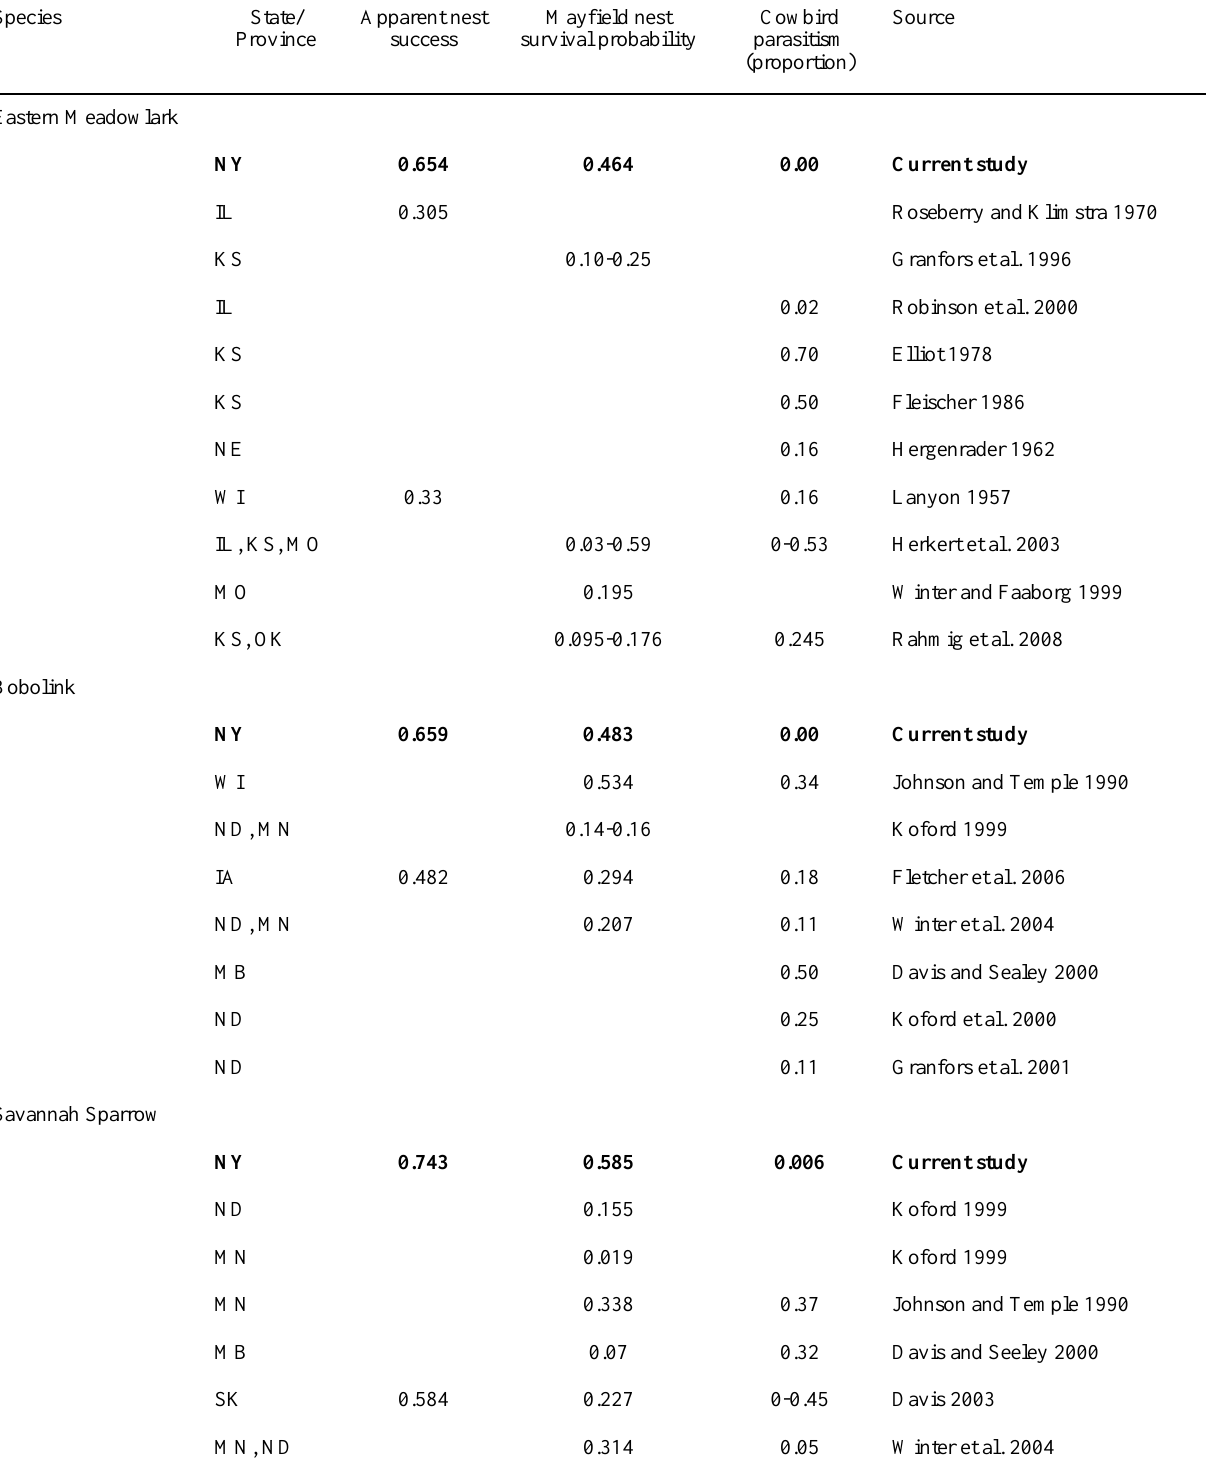
Table 4. Breeding biology data for Eastern Meadowlarks, Bobolinks, and Savannah Sparrows from midwestern North America and the current study